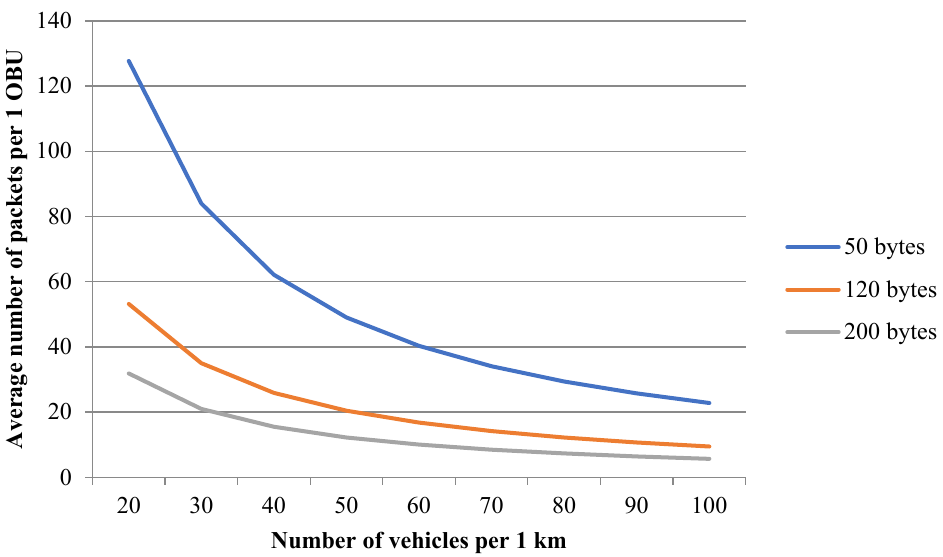
Figure 4. The average number of packets per OBU at the 2nd confidentiality level.